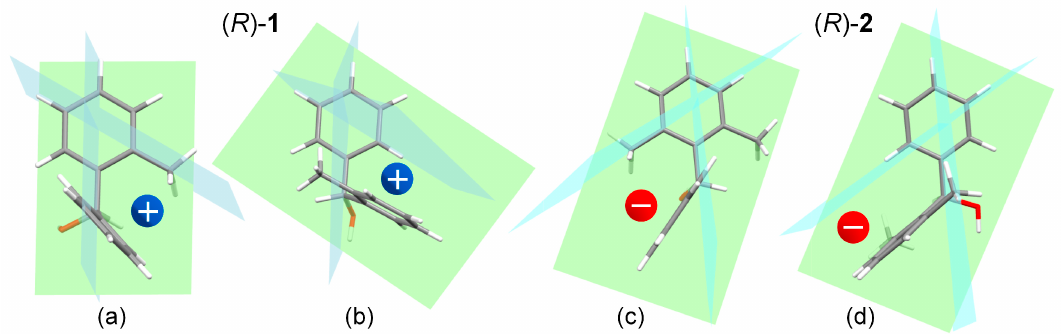
Figure 8. Application of the sector rule for 1 L b ECD band to ( R )- 1 (conformer #2) and ( R )- 2 (conformer #1). The colored spheres indicate the dominant contribution of one benzene acting as a perturber for the other ring. Structure ( a ), sector contribution of the phenyl ring on the 2-methylphenyl ring in ( R )- 1 ; ( b ), contribution of 2-methylphenyl on phenyl in ( R )- 1 ; ( c ), contribution of phenyl on 2,6-dimethylphenyl in ( R )- 2 ; ( d ), contribution of 2,6-dimethylphenyl on phenyl in ( R )- 2 .